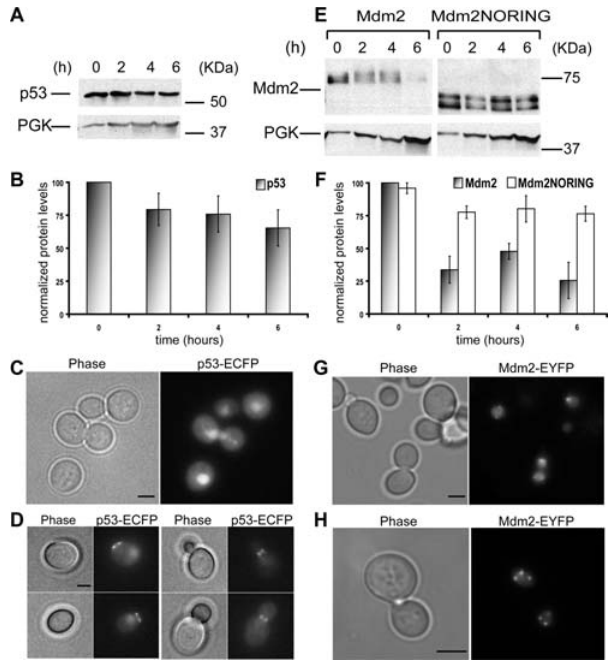
Figure 1. Stability and localization of the human p53 and Mdm2 proteins in yeast. (A) Total yeast cell extracts from exponentially growing cells were immunoblotted for p53 over time. 3-phosphoglyc- erate kinase (PGK) was used as loading control. (B) Quantifications of p53 protein levels are shown. Data represent the mean 6 standard error (SE), for n = 3 independent experiments. (C,D) Maximum projections from fluorescence image stacks of live yeast cells expressing p53-ECFP were obtained with a DeltaVision workstation. Bar, 2 m m. E,F,G,H. Same as in (A,B,C,D) but for Mdm2.